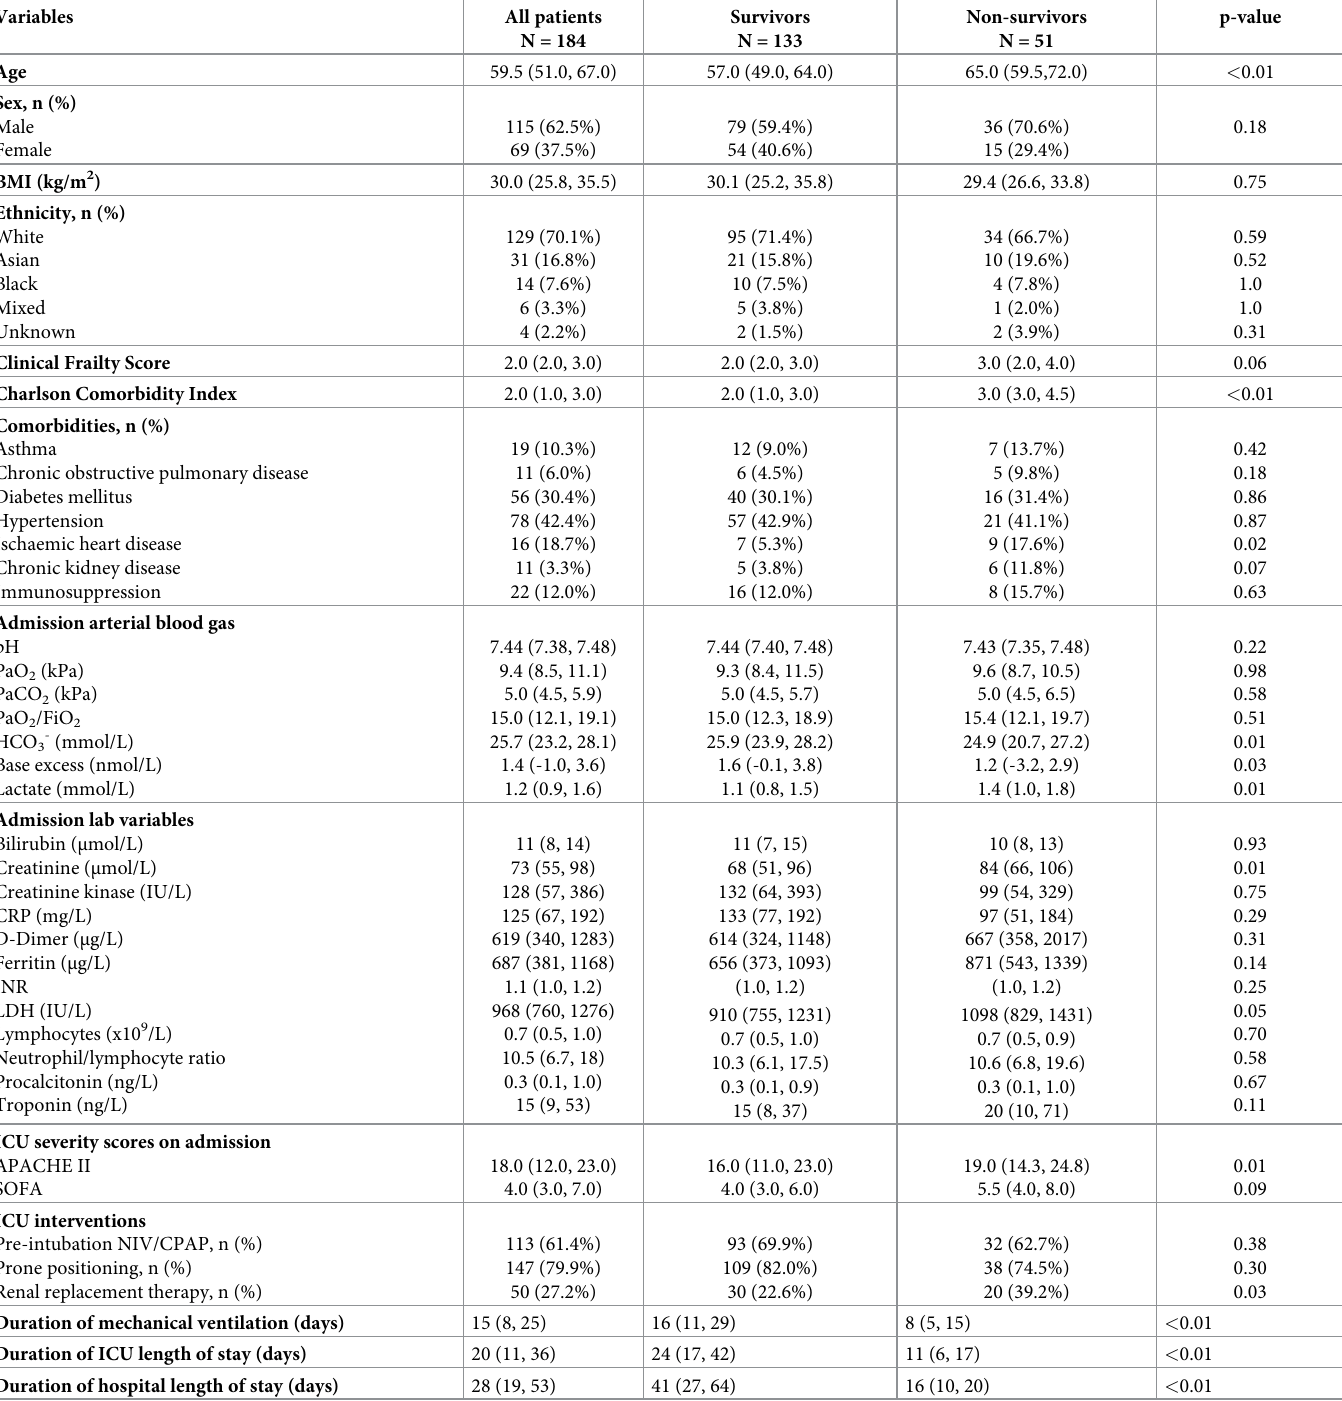
Table 1. Patient characteristics and outcomes of all patients meeting inclusion criteria (n =